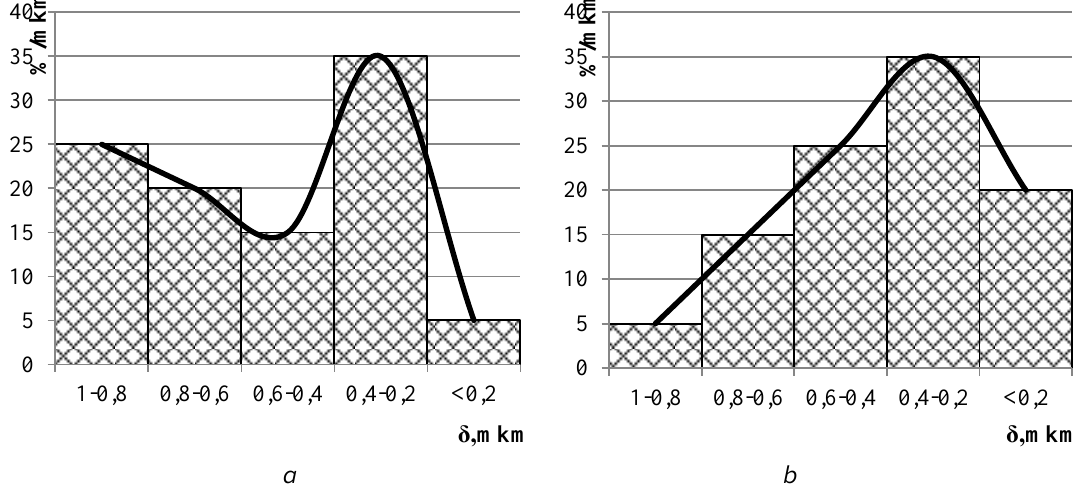
Fig. 2. Differential curve of particle distribution by microscopic study: a – diosmin; b – hesperidin